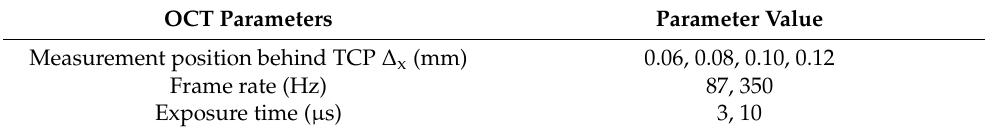
Table 1. OCT parameters with parameter values.